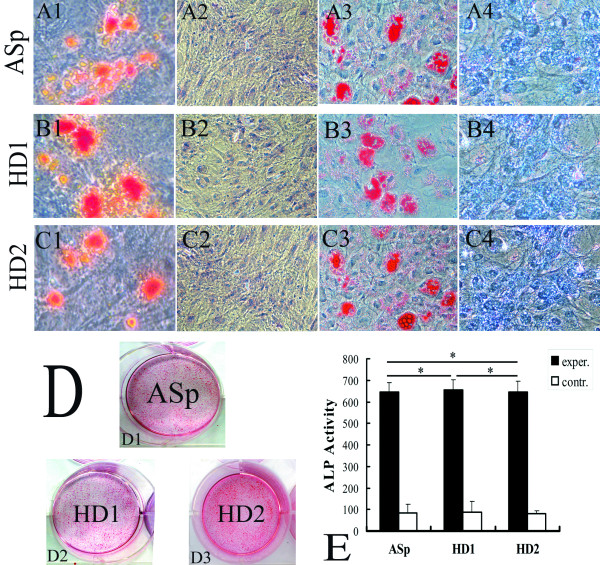
Bone marrow-derived mensenchymal stem cell triple differentiation potentials from ankylosing spondylitis patients and healthy donors. (A), (B), (C) Morphological characteristics of bone marrow-derived mensenchymal stem cells (BMSCs) for osteogenic, adipogenic and chondrogenic differentiation evaluated by the inverted phase contrast microscope; ankylosing spondylitis (AS)-BMSCs have the same morphological properties as the HLA-B27-negative healthy donor (HD1)-BMSCs and HLA-B27-positive healthy donor (HD2)-BMSCs. Osteocytes were stained for calcium deposition using Alizarin Red-S (A1, B1, C1: x400) and for alkaline phosphatase (ALP) with the Cell Alkaline Phosphatase-S assay (A2, B2, C2: x200). Adipocytes were filled with many fat vacuoles, and Red Oil O was used to stain the fat vacuoles of adipocytes (A3, B3, C3: x200). Chondroblast differentiation from BMSCs was identified with Alcian blue staining (A4, B4, C4: x200). (D) General photographs of BMSCs for osteogenic differentiation, stained with Alizarin Red-S. (E) ALP activities of AS-BMSCs, HD1-BMSCs and HD2-BMSCs were 644 ± 45, 655 ± 49 and 646 ± 51, respectively; differences not statistically significant (P > 0.05). Data presented as mean ± standard deviation. MLR, mixed peripheral blood mononuclear cell reaction; PHA, phytohemagglutinin.